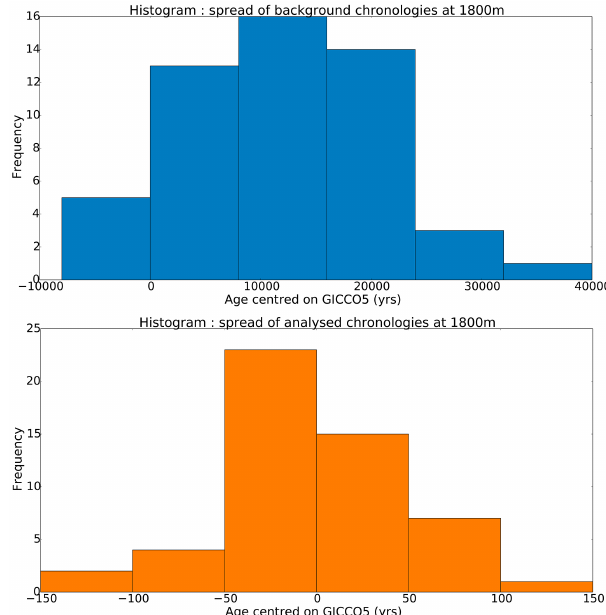
Figure 3. Twin experiments: (top) histograms of the 51 perturbed background (blue) and (bottom) the corresponding 51 analysed chronologies, i.e. output chronologies from Datice (red) at 1800m depth for NGRIP ice